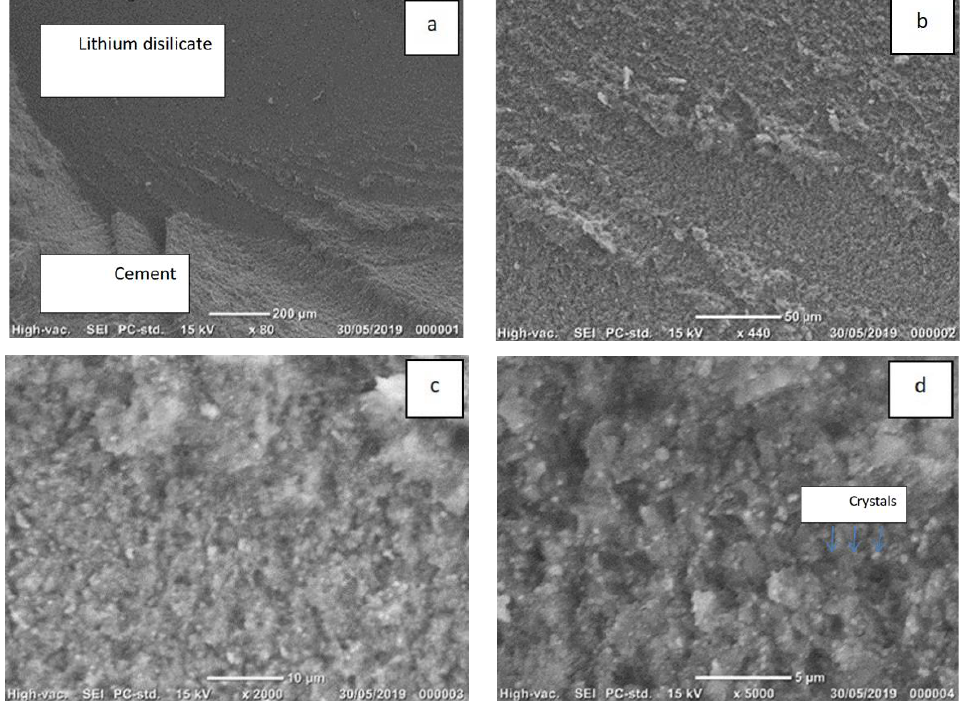
Figure 4. ( a – d ) Scanning electron images of the mixed mode failure in a representative sample of Group 4 (9% HF for 90 s). ( a , b ). Lithium disilicate surface covered partly with cement (×440) ( c , d ). The higher acid concentration caused further degradation and more surface irregularities in the ceramic. Lithium disilicate crystals are visible at lower (×2000) and higher (×5000) magnifications following the removal of the glassy phase.